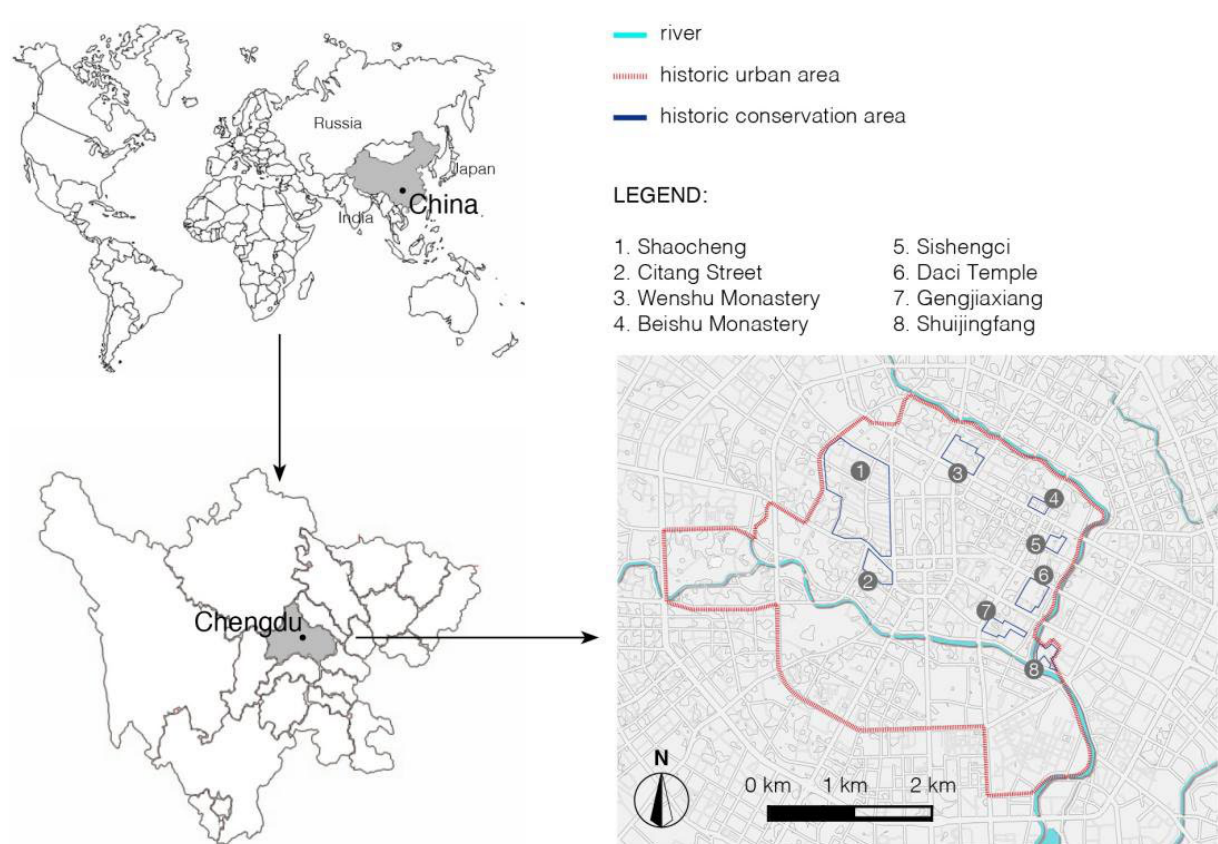
Figure 1. The location of the study area and distribution of historic conservation areas in Chengdu.